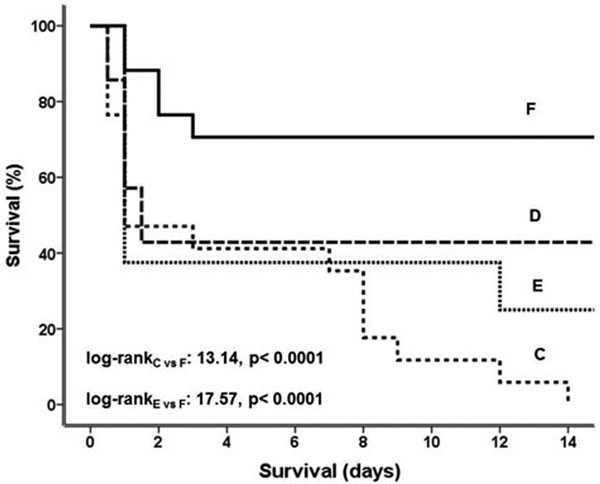
Survival of rats.